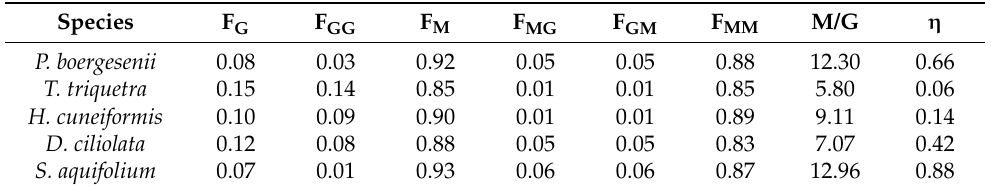
Table 4. Compositional data of the alginates extracted.